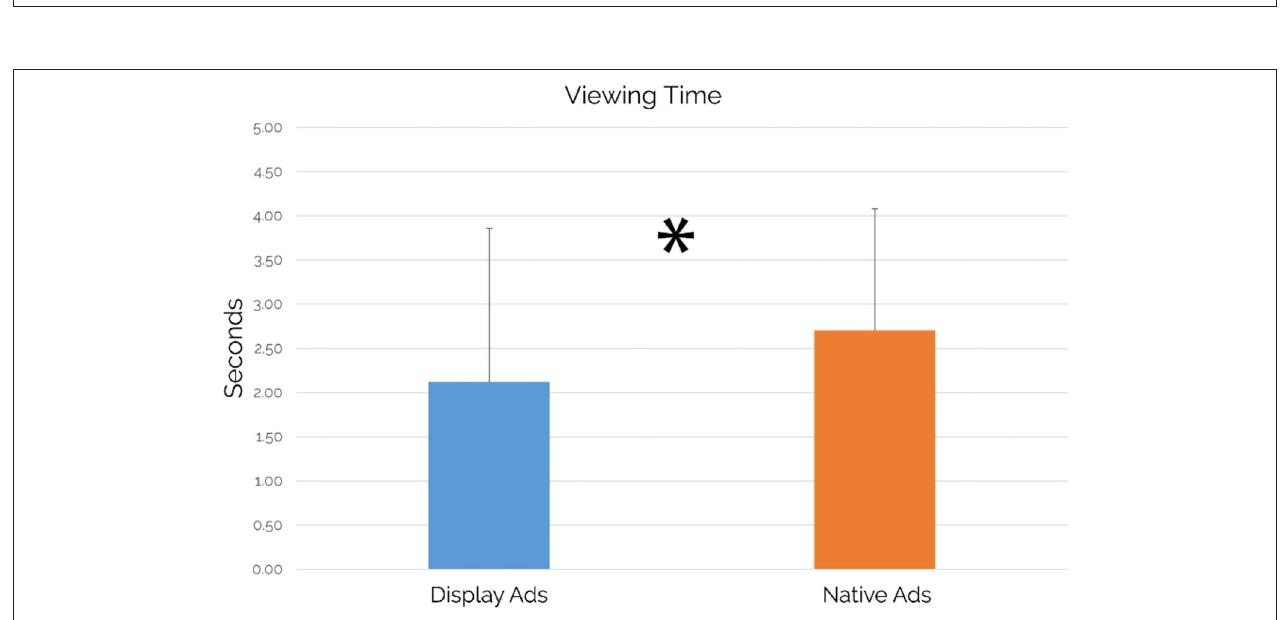
FIGURE 5 | Visual attention: comparison between the display and native ads ( n = 49). Native ads showed a statistically significant increase in visual attention values in comparison to display ads ( p = 0.021, d = 0.35). Error bars represent SD.